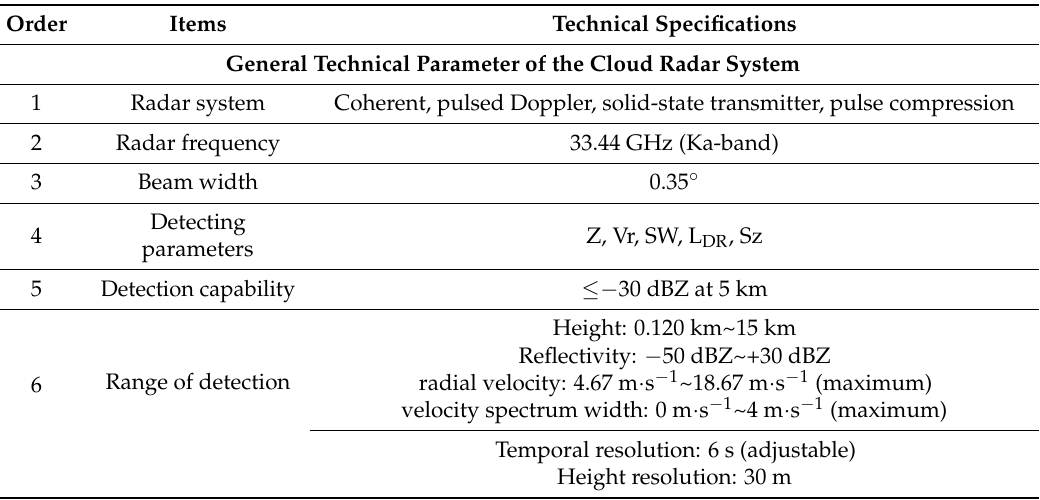
Table 1. Main technical parameters for the Ka band solid-state transmitter cloud radar.